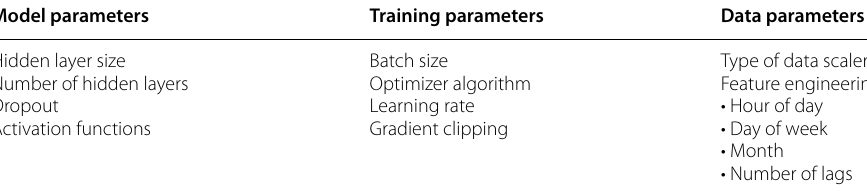
Table 4 Tunable